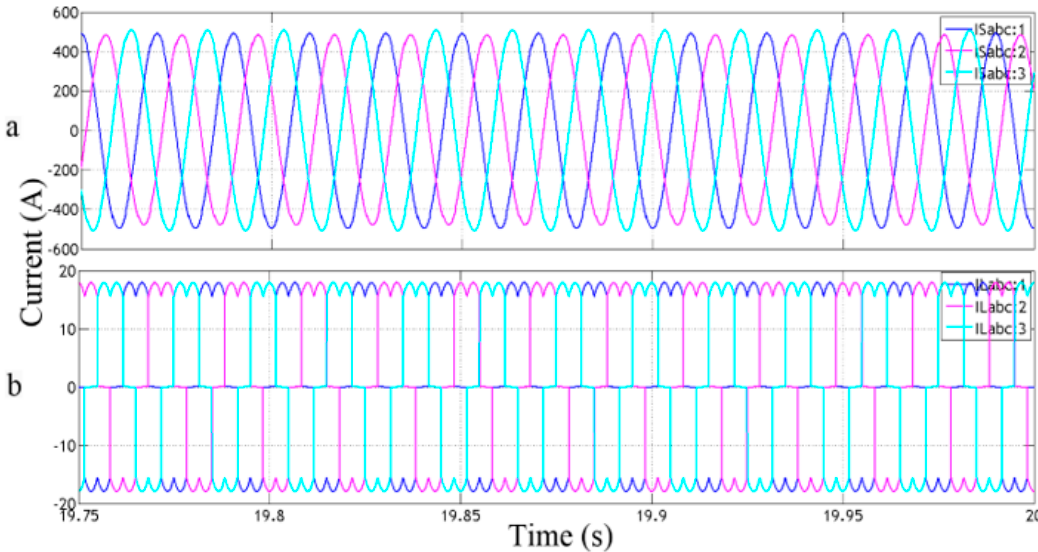
Figure 20. After compensation unbalanced system ( a ) source current; ( b ) load current.